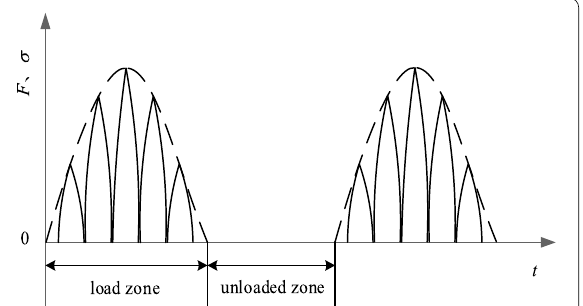
Figure 6 Contact load and stress distributions at each point of the rotating ring